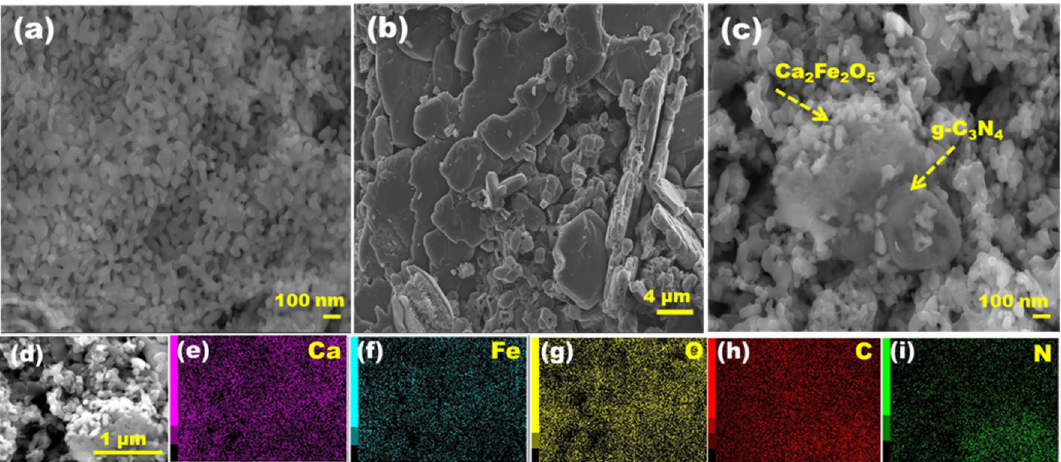
Figure 2. SEM images corresponding to ( a-c ) CFO, g-C 3 N 4 and CCN50 ( d–i ) EDS mapping images of CCN50 sample showing uniform distribution of Ca, Fe, O, C and N elements.